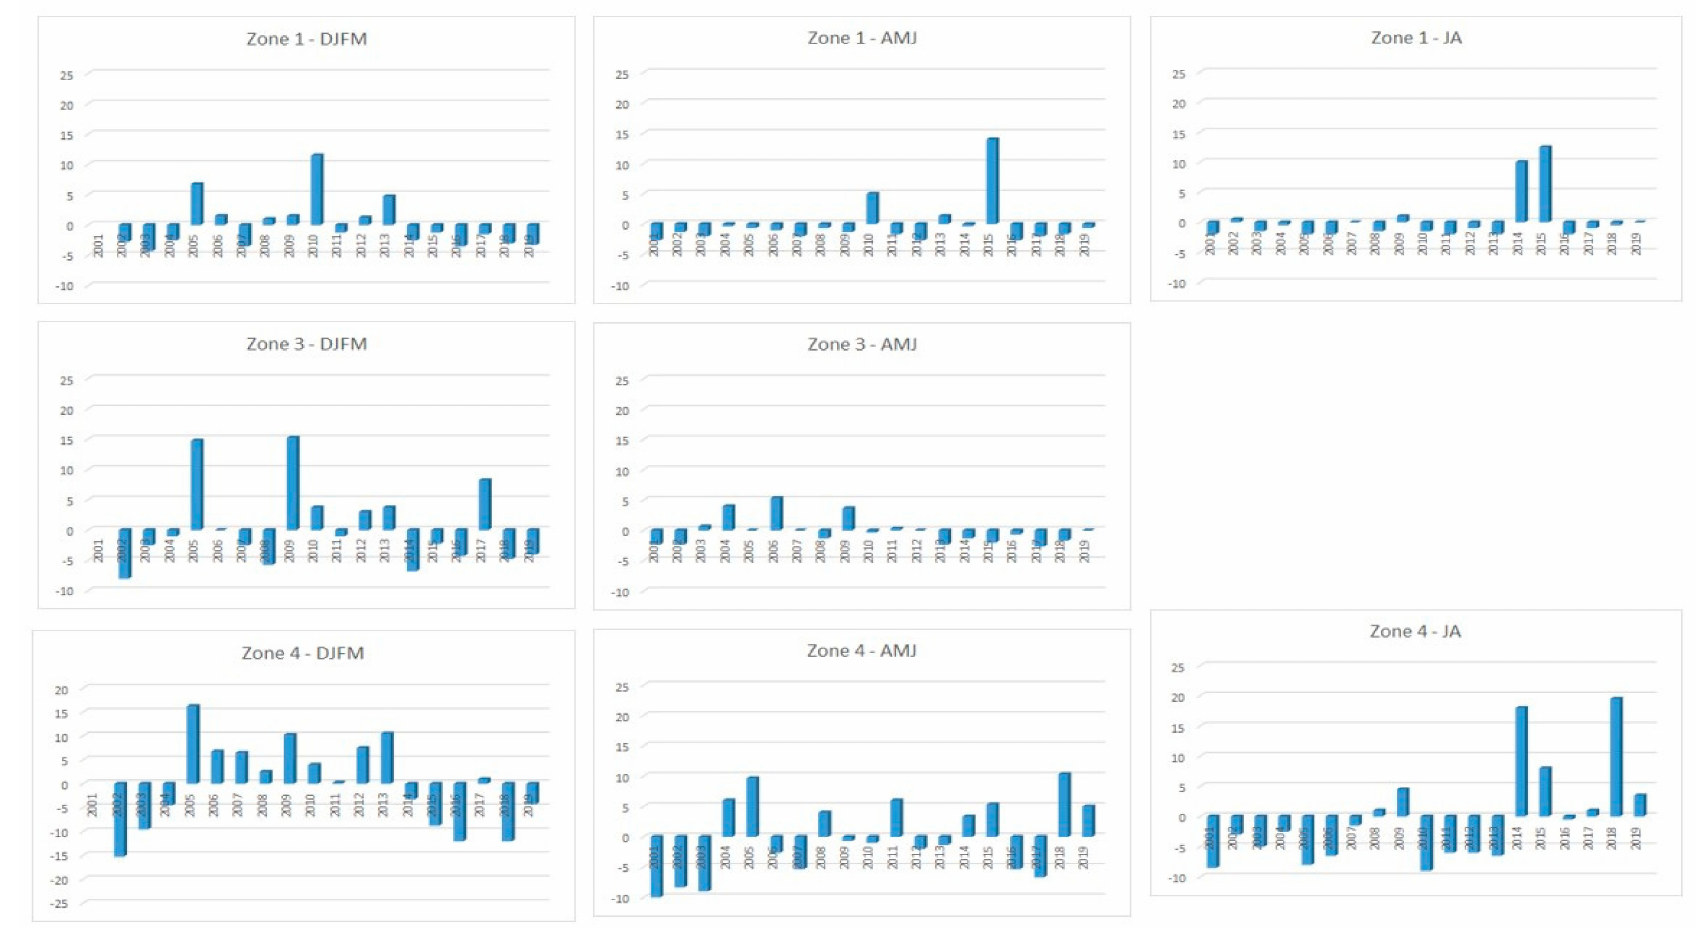
Figure 7. Anomalies of Seasonal fire frequency for zones 1, 3 and 4 for the seasons DJFM, AMJ and JA. Zone 3—JA is omitted since no fire is recorded for most